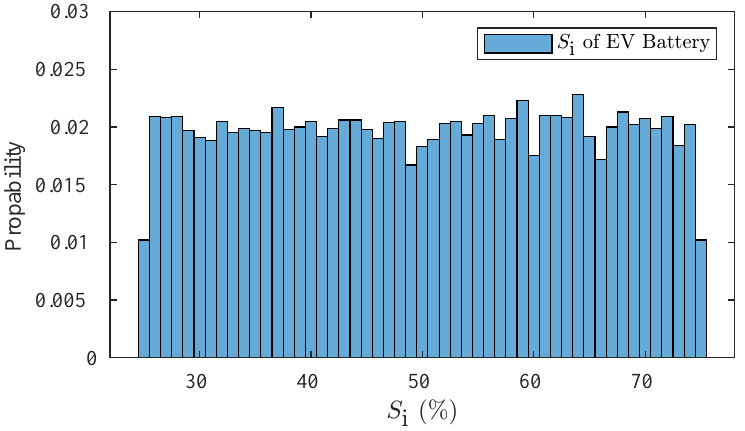
Figure 4. Distribution of the initial SOC, S i , where the uniform distribution is considered.